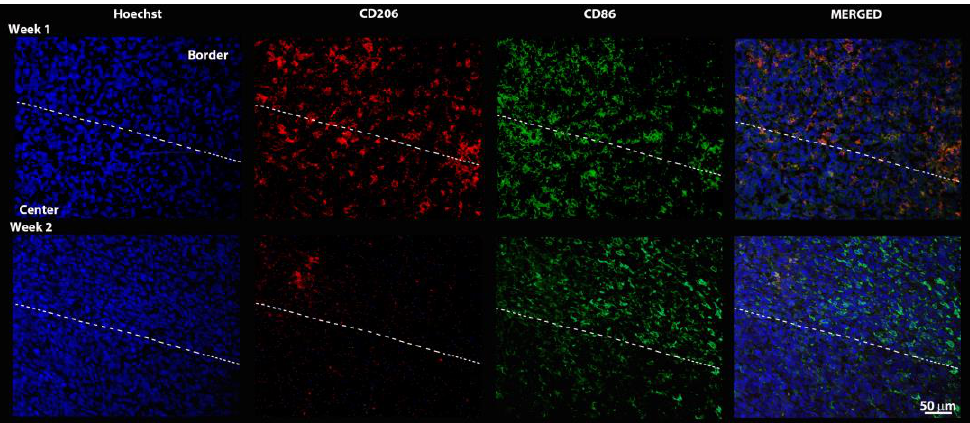
Figure 7. Images of immunofluorescence reactions in tumor tissue with Hoechst dye (Nucleus), TSPO, CD11 (macrophages), and fusion of all three. The dashed line divides the tissue sections into an upper (edge) and lower (center) region.